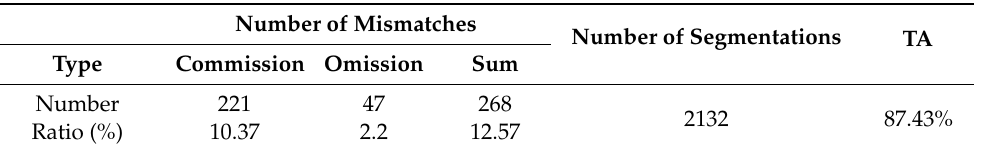
Table 4. Accuracy assessment of individual tree segmentation in spatial position aspect. TA denotes the total accuracy of individual